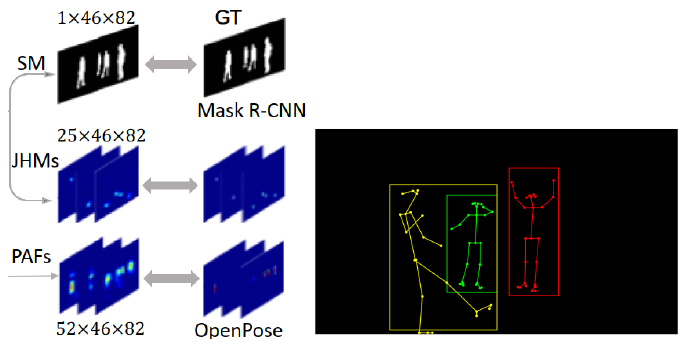
Figure 12. SM, JHMs, and PAFs are used for joint association to generate multiple person skeletons [48].